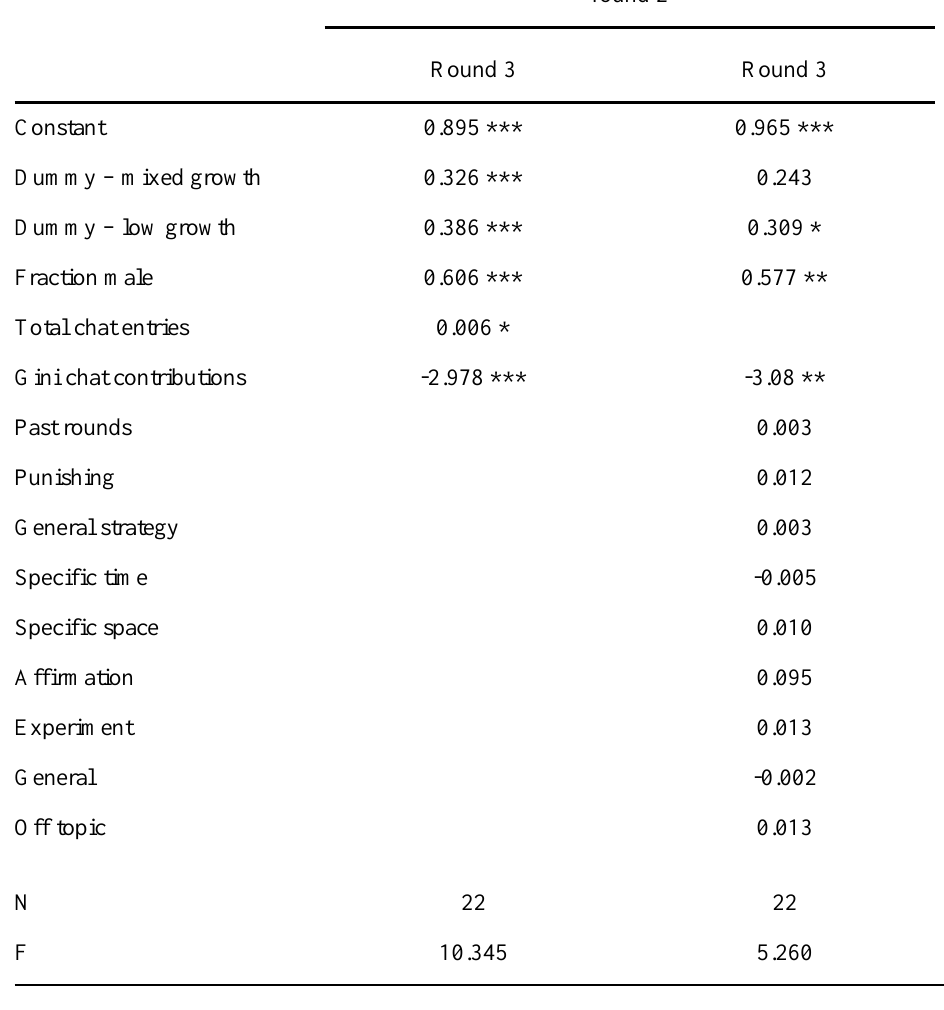
Table 6. The statistical estimation of the relationship between relative increases of tokens collected in round 3 vs. round 2 and the communication